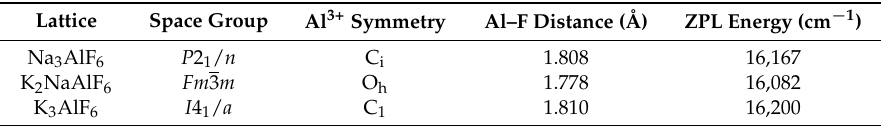
Table 2. Space group, Al 3+ site symmetry and average Al–F distance for M 3 AlF 6 (M = Na, K); zero-phonon line (ZPL) energy of the Mn 4+ 2 E → 4 A 2 emission in M 3 AlF 6 :Mn 4+ . Structural data obtained from Refs. [29–31].